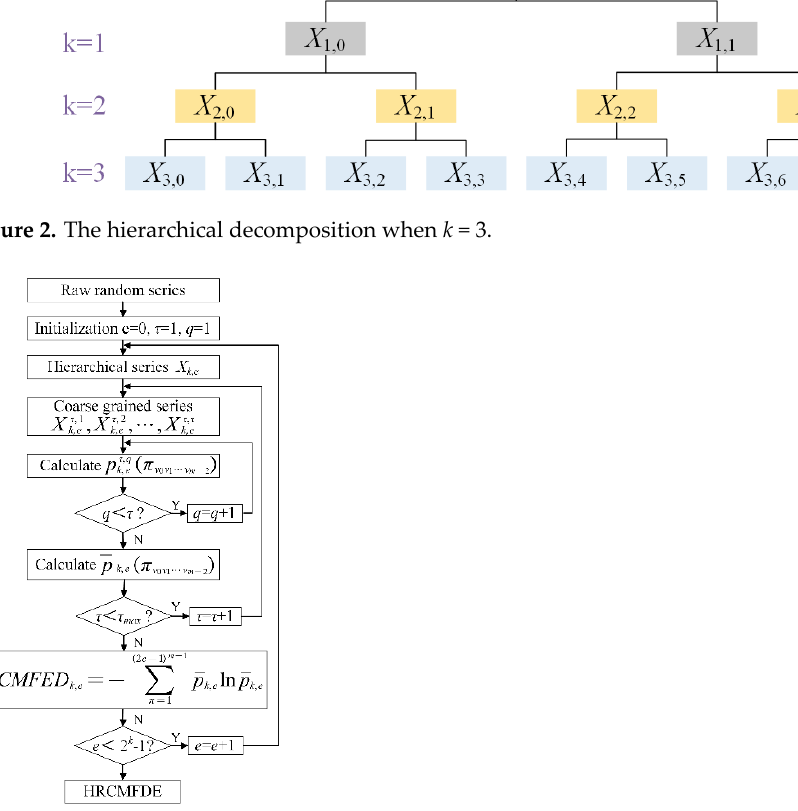
Figure 2. The hierarchical decomposition when k = 3.